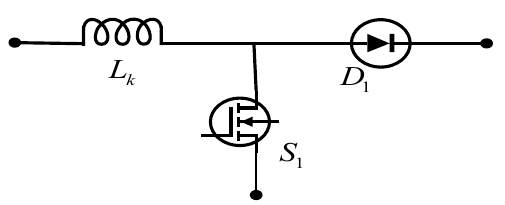
Figure 13. Pictorial representation of double switch connection.